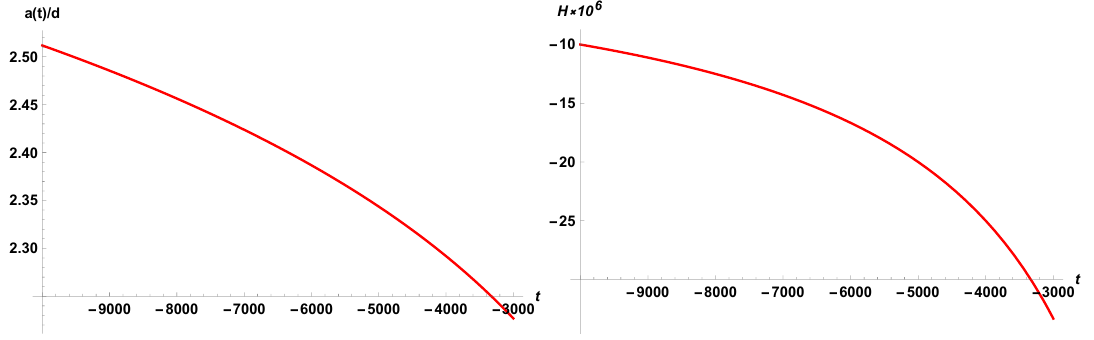
t - 9000 - 8000 - 7000 - 6000 - 5000 - 4000 - 3000 Figure 10 . The scale factor a ( t ) divided by d (left panel) and the Hubble parameter H ( t ) (right panel) in Jordan frame in the model with χ = 0 . 1 , n S = 1 , and µ = 1